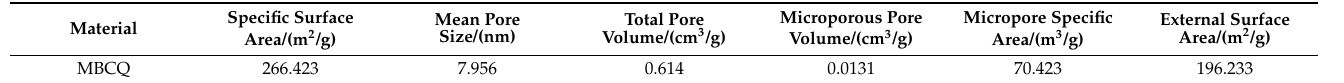
Table 7. BET specific surface area and pore characteristics of MBCQ.